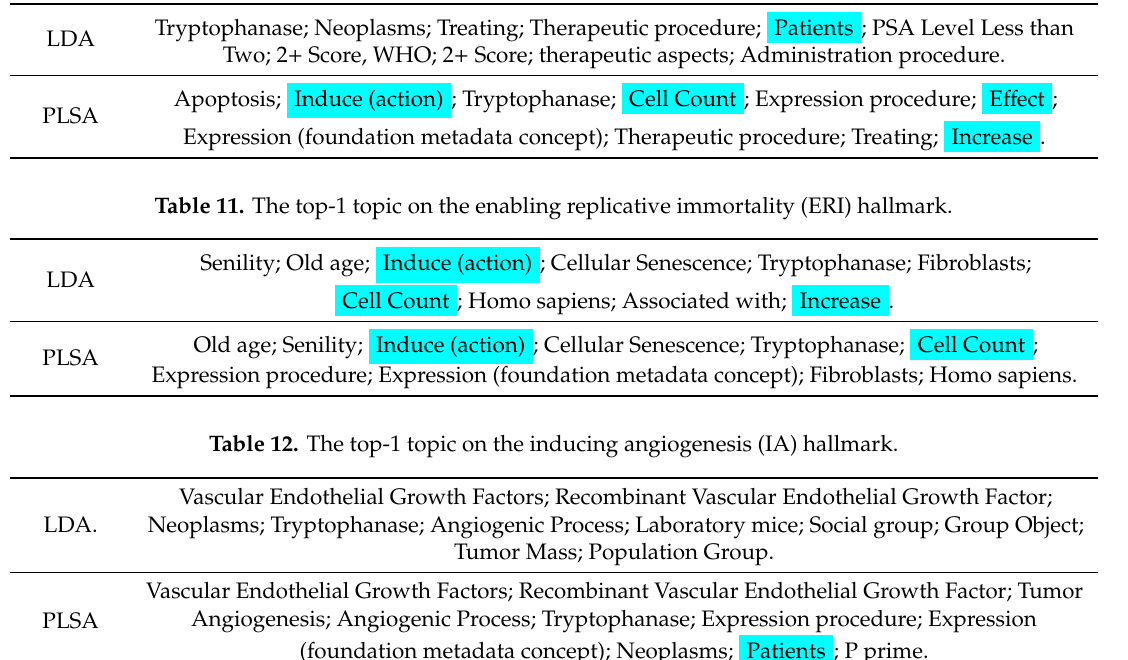
Table 10. The top-1 topic on the resisting cell death (RCD) hallmark.